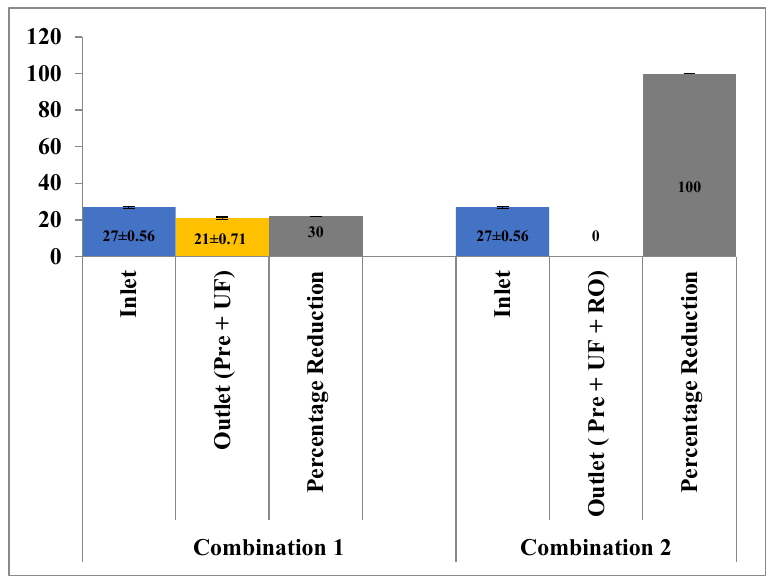
Figure 7. Effect of different treatment setups on the BOD rejection . Pre-filtration and UF in series could reduce the color from 412 ± 21.10 PCU to 108 ± 10.2 PCU, i.e., by 73.78% (Figure 8). Lignin is the main component of color addition in the paper industry. In terms of lignin removal from the effluent, the pre-filtration and UF membrane fared significantly better as they were able to reduce 83% (126 ± 7.71 mg/L to 22 ± 1.01 mg/L) of the lignin although the additional RO membrane could effectively reduce the entire lignin content (100%) from the effluent (Figure 9). The application of nanofiltration by the authors of [21] on textile industry wastewater reduced the color by 100%. Similarly, the use of ultra-filtration alone rejected 98% of the synthetic dye from synthetic dye wastewater [22]. Figure 8. Effect of different treatment setups on the color rejection .